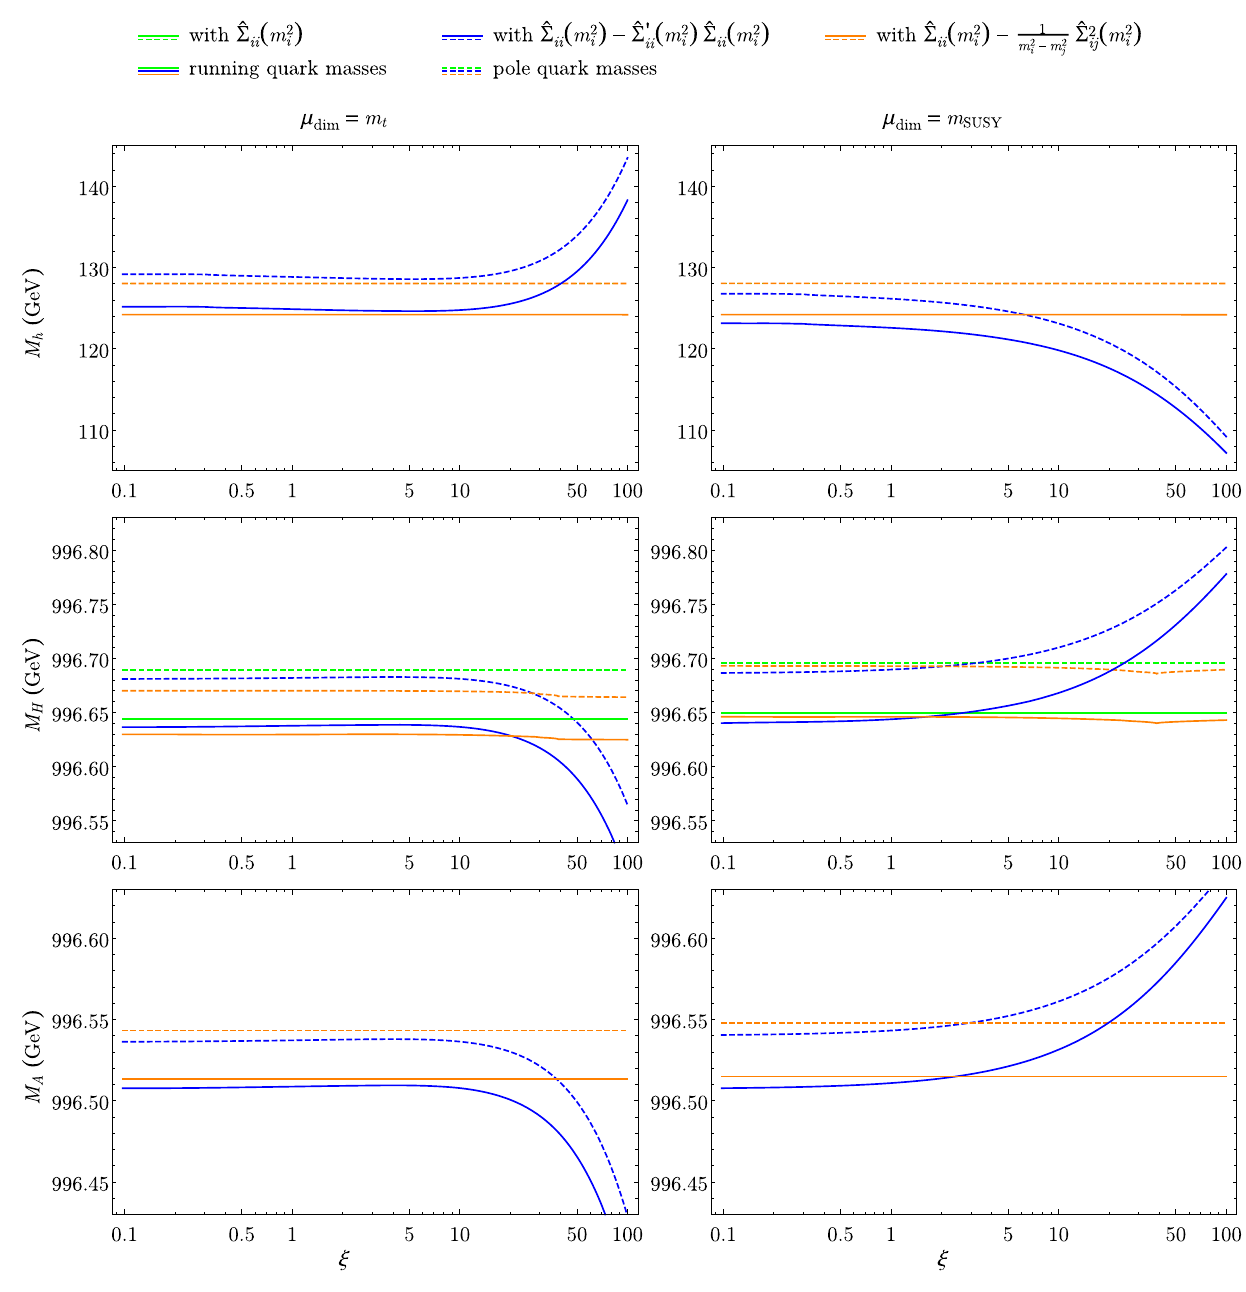
Fig. 1 The gauge dependence of the MSSM Higgs masses is shown for m H ± = 1TeV, t β = 10. The horizontal green lines correspond to the expansion of one-loop order as in Eq.(4). The blue curves corre- spond to the ξ -dependence originating from the diagonal self-energy (the off-diagonal terms are set to 0) as in Eq.(5). In the orange curves (on top of the green curves for M h and M A ), the momentum in the diag- onal self-energy is evaluated at the tree-level mass, so that no gauge- dependenceisintroducedbythisterm,andthe ξ -dependenceoriginating from the off-diagonal terms – see Eq.(7) – is studied. The plots on the left-hand side are obtained for the renormalization scale μ dim = m t ,